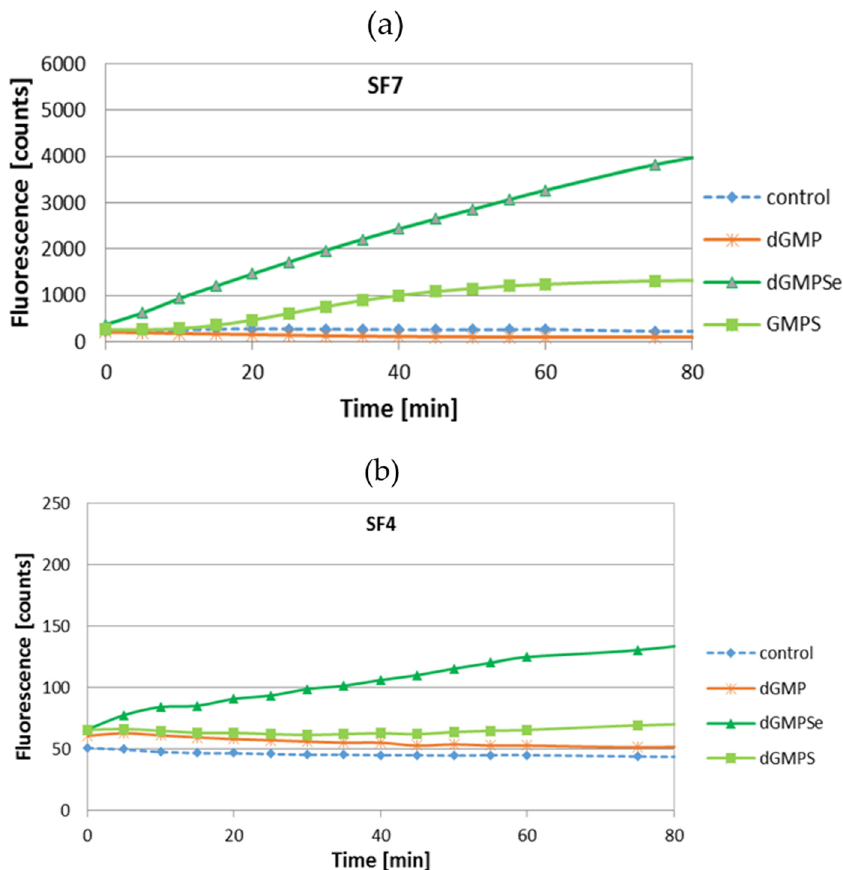
Figure 4. Time course of the release of H 2 Se, shown as fluorescence values in the reaction of dGMPSe with HINT1 (fluorescence assay). Fluorogenic SF7 ( a ) or SF4 ( b ) probes were used. Reactions were performed in triplicate.